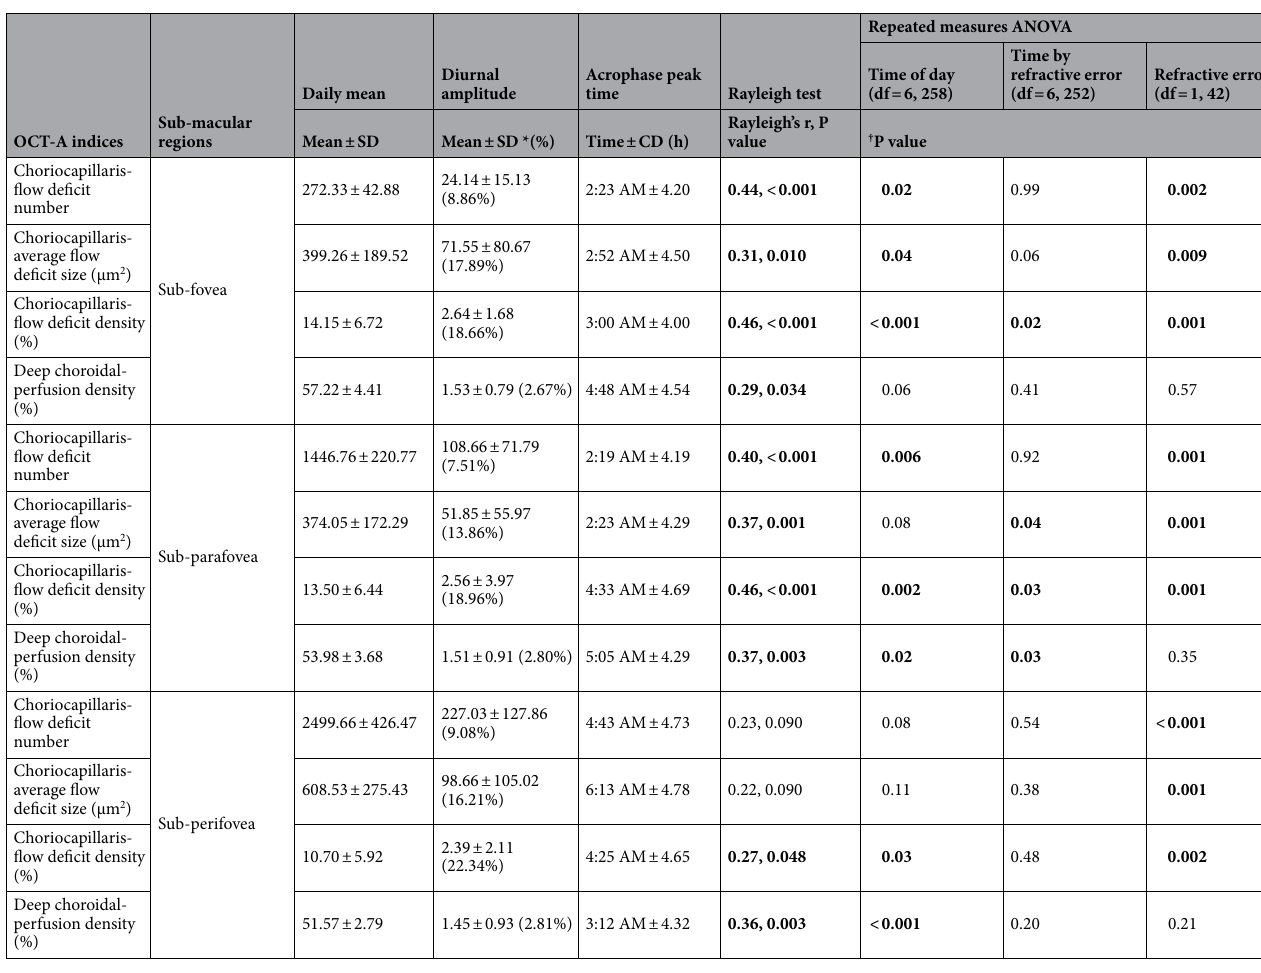
Table 1. Daily mean, amplitude of diurnal variation, acrophase, Rayleigh test results and repeated measures ANOVA (analysis of variance) outcomes for the choriocapillaris and deep choroidal OCT-A indices of the sub-foveal, sub-parafoveal and sub-perifoveal regions for all participants. *Diurnal amplitude is also expressed as the percentage of the daily mean value. † P values from repeated measures ANOVA for time of day, refractive error, and time by refractive error. P < 0.05 is highlighted in bold. SD standard deviation, CD circular deviation, df degree of